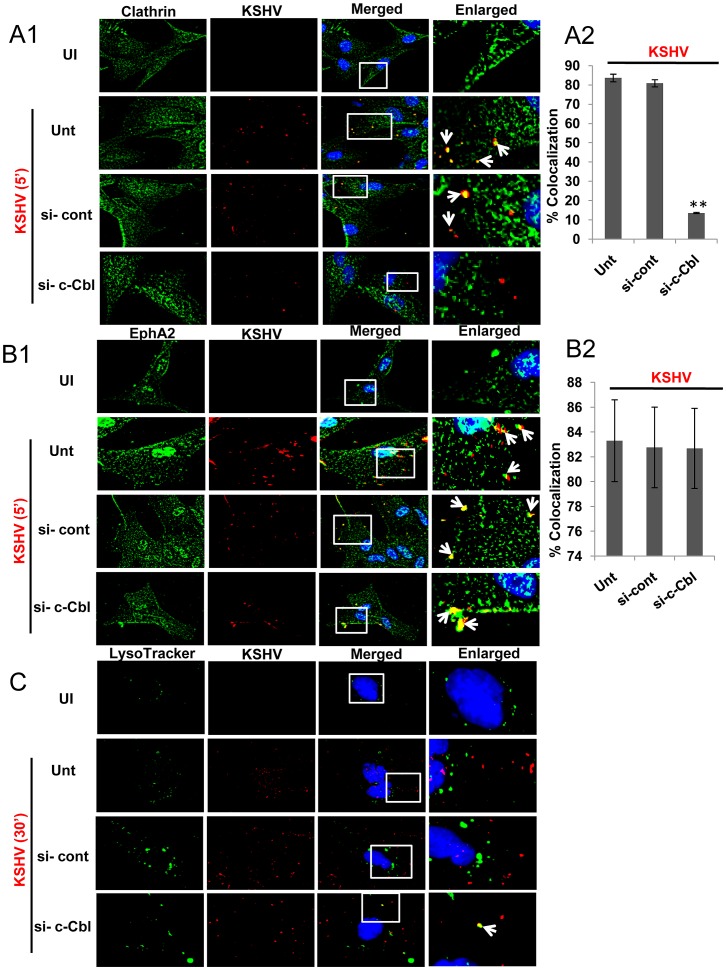
c-Cbl regulates clathrin mediated productive entry of KSHV without affecting its association with EphA2.(A and B) Serum starved, control si-RNA or c-Cbl-si-RNA transfected, HFF cells either uninfected or infected with KSHV for 5 min were subjected to immunofluorescence assay using anti-rabbit KSHV gB and mouse anti-clathrin antibodies (A1) or anti-rabbit EphA2 and anti-mouse KSHV gpK8.1 antibodies (B1), respectively, overnight at 4°C followed by staining with either anti-rabbit Alexa 594 and anti-mouse Alexa 488 (A1) or vice versa (B1). Representative 2D convoluted images are shown. The enlarged pictures represent boxed regions within the merged panels and the white arrows represent colocalization of the indicated molecules. (A2 and B2) Quantification of KSHV colocalized with clathrin or EphA2 was performed by counting three different fields having atleast 10 cells each and error bars represent mean ± SD, ** represents p<0.01. (C) Control or c-Cbl-si-RNA-transfected HFF cells were incubated with medium containing LysoTracker green along with or without KSHV (30 DNA copies/cell) for 30 min at 37°C and were processed for immunofluorescence assay using anti-gB antibody followed by Alexa 594 anti-rabbit secondary antibody. Representative 2D convoluted images are shown. The white boxes within the merged panels are shown as enlarged pictures and the white arrows represent colocalization of the indicated molecules.